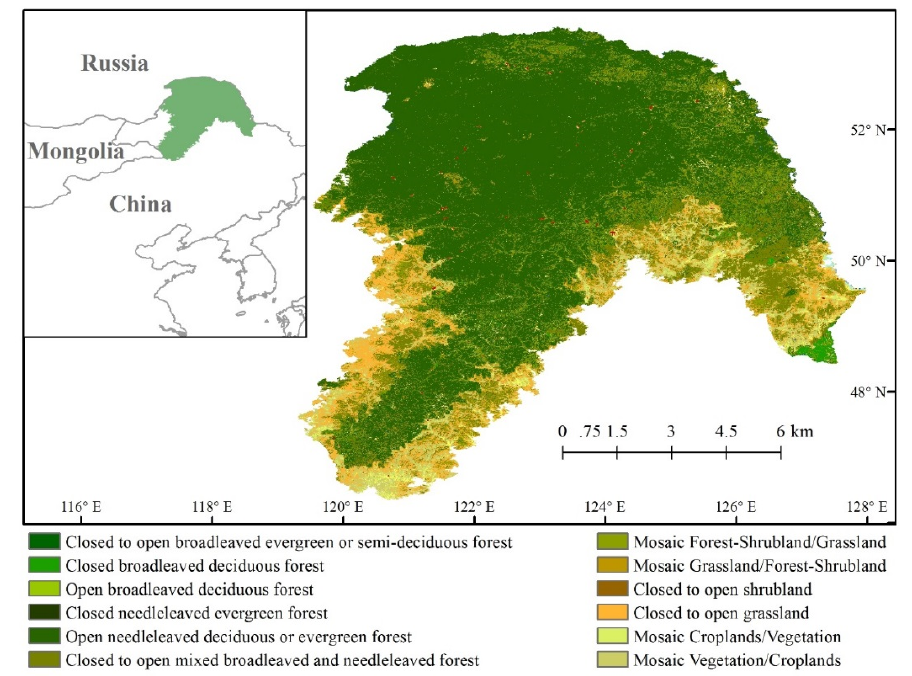
Figure 1. Study region location and land cover. Land cover data were obtained from the global land cover (2009) of the European Space Agency ( http://ionia1.esrin.esa.int/ ) [38,39].